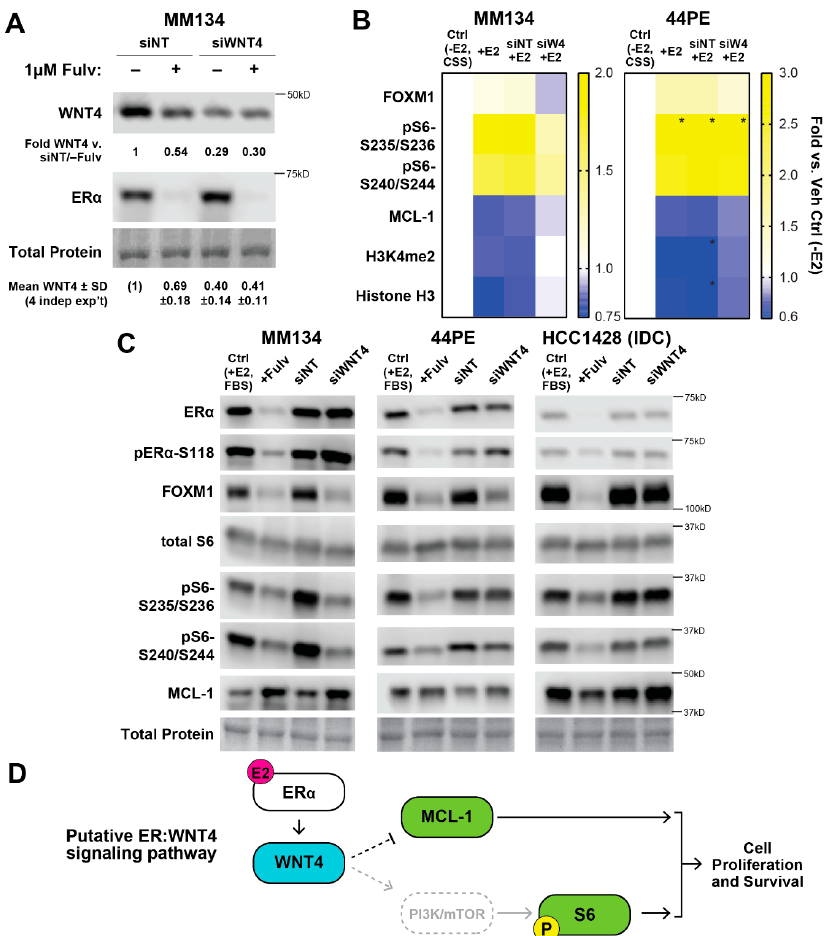
Figure 2. WNT4 is required for key components of estrogen receptor (ER) signaling. ( A ) MM134 cells in full serum were reverse transfected with the indicated siRNA. Then, 24 h later, cells were treated with fulvestrant, and lysates were harvested after an additional 24 h (48 h post-transfection). Total protein detected with Ponceau staining, quantification is vs. total protein. Average quantification from 4 independent experiments shown at bottom. ( B ) E2-driven RPPA signaling from Figure 1 ( n = 18) were compared to siRNA targeting WNT4 (siWNT4) RPPA targets from Figure S2 ( n = 52), identifying 6 targets for which siWNT4 suppressed E2-driven signaling. Mean signal of biological triplicate shown, fold vs. veh control (-E2). * value outside scale. ( C ) Targets from (B) were validated using the reciprocal treatment approach vs. RPPA analyses. Cells in complete fetal bovine serum (FBS) were treated with fulvestrant (Fulv) to block ER signaling or transfected with siRNA as indicated. Total protein by Ponceau staining, quantification in Figure S2D. ( D ) WNT4 is required for E2-mediated regulation of mTOR signaling and MCL-1 levels, which may mediate ILC cell proliferation and survival.